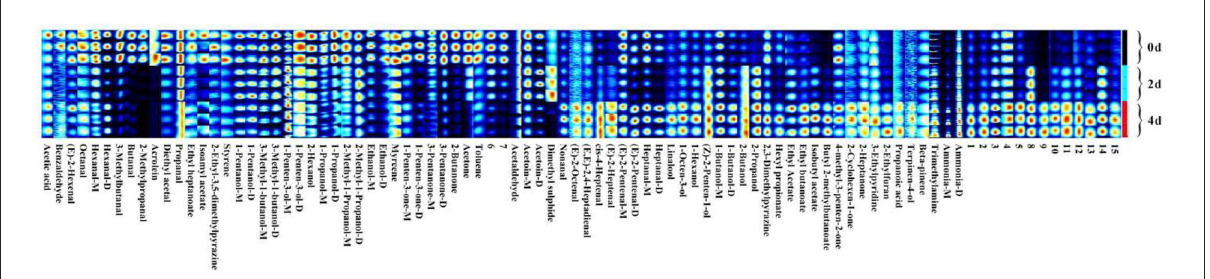
FIGURE4 Fingerprint of volatile substances in hairtails.